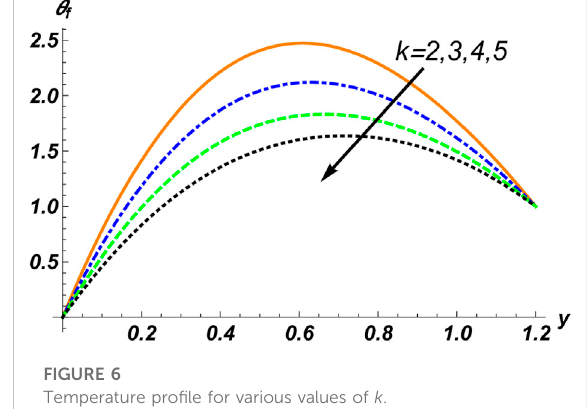
Temperature pro fi le for various values of k .